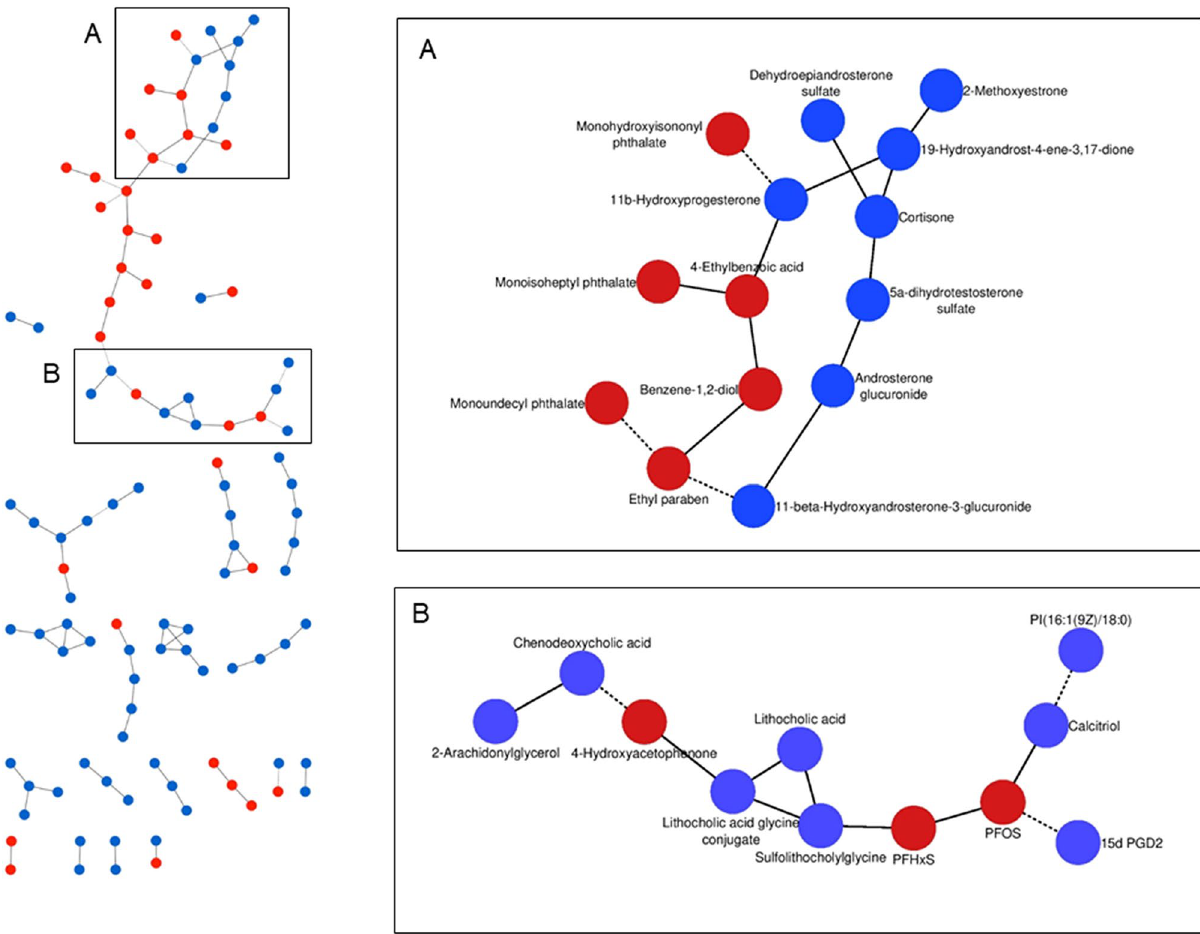
Figure 3. Exposure-metabolites subnetworks identified by the GGMs inferred from the women FF metabolomics dataset. The subnetwork A represents associations of phenols and phthalates with metabolites involved in steroid hormone biosynthesis. The subnetwork B shows associations between 4-hydroxyacetophenone, PFOS and PFHxS and metabolites involved bile acids, arachidonic and vitamin D metabolism. Blue and red nodes represent endogenous metabolites and environmental chemicals, respectively. Plain and dashed edges connecting nodes represent positive partial correlations and negative partial correlations, respectively. Edges connecting nodes represent significant partial correlations at FDR <